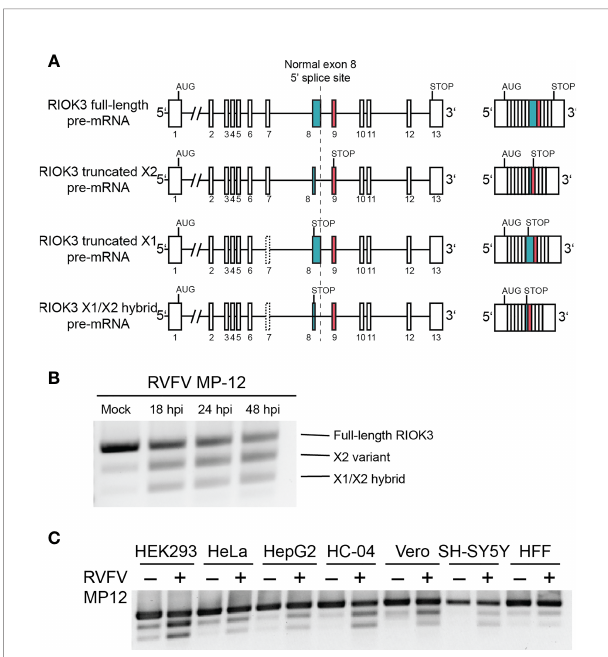
FIGURE 1 | RIOK3 mRNA is alternatively spliced during RVFV infection in multiple cell types. (A) Schematic illustration of RIOK3 splice sites observed. Single lines are introns, while boxes are exons. (B) RT-PCR visualized by agarose gel showing alternative splicing of RIOK3 pre-mRNA after infection with RVFV MP-12 at MOI = 1. (C) RT-PCR showing RIOK3 alternative splicing in multiple cell lines in response to RVFV MP-12 infection. HEK293 (human embryonic kidney), Hela (human cervical carcinoma), HEPG2 (human hepatoma), HC-04 (human hepatoma), Vero (African green monkey kidney), SH-SY5Y (human neuroblastoma), and HFF (human foreskin fi broblast) were